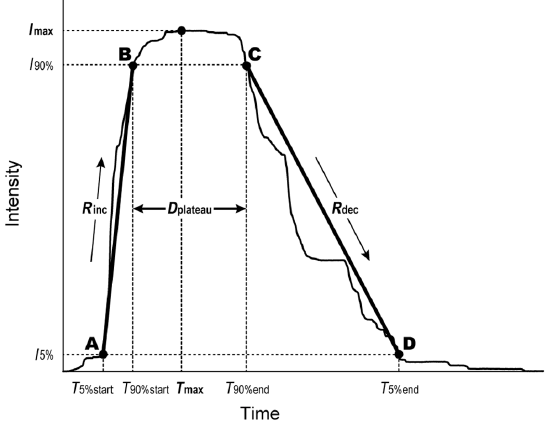
Figure 2. Calculation model for TI parameter. I max : maximum intensity; T max : time point at which intensity reached the maximum value; D plateau : duration between T 90%start and T 90%end ; R inc : rate of intensity increase between T 5%start and T 90%start ; R dec : rate of intensity decrease between T 90%end and T 5%end .